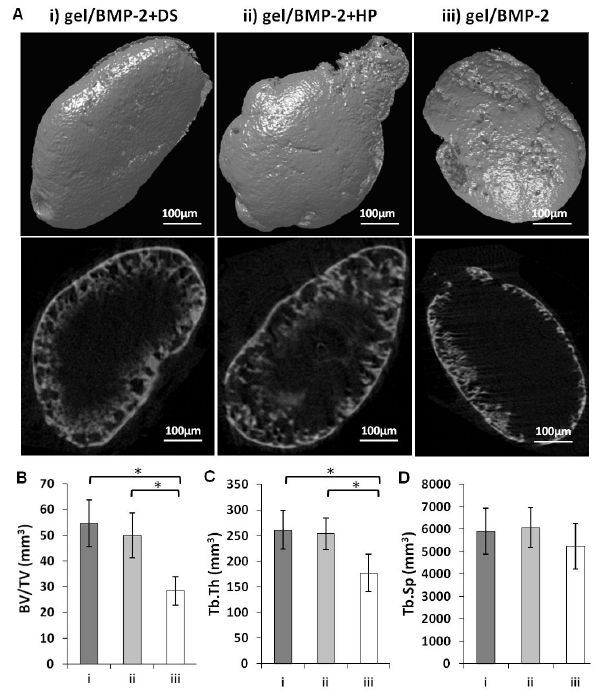
Figure 3. Micro-CT analysis. (A) 3D (upper row) and 2D (lower row) image of the surface of ectopic bones formed 6 weeks post-injection of (i) gel/BMP-2+DS, (ii) gel/BMP-2+HP and (iii) gel/ BMP-2. (B) The average bone volume/tissue volume (BV/TV) ratio, (C) the average trabecular thickness (Tb.Th.) and the average trabecular separation (Tb. Sp.) were calculated, and the values represent the mean ± SD for n=6;